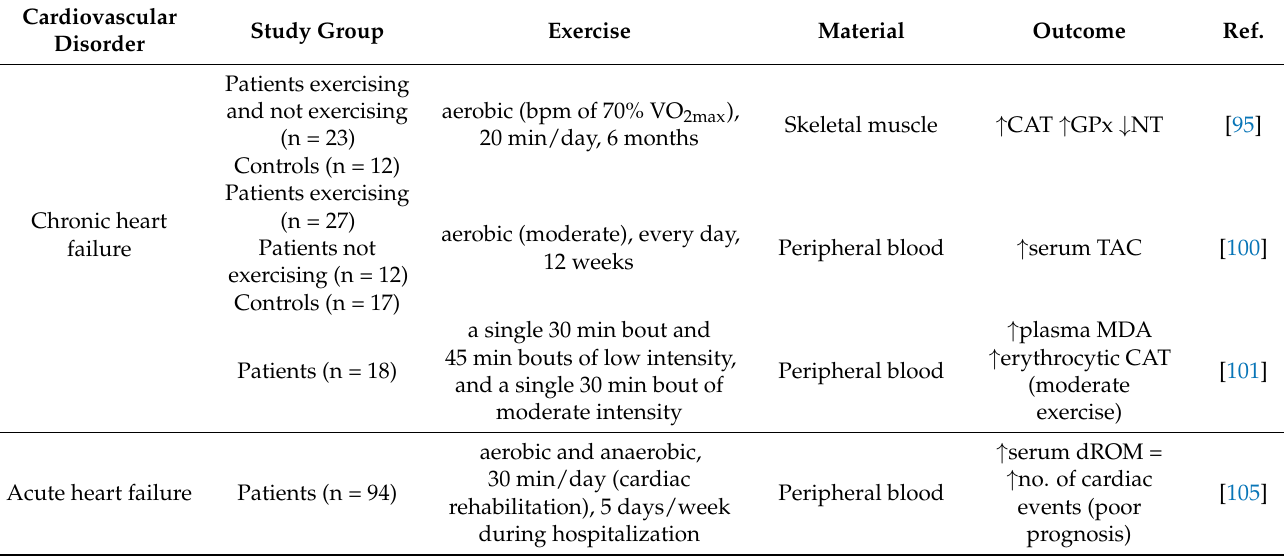
Table 1. Exercise impacts on redox balance in cardiovascular